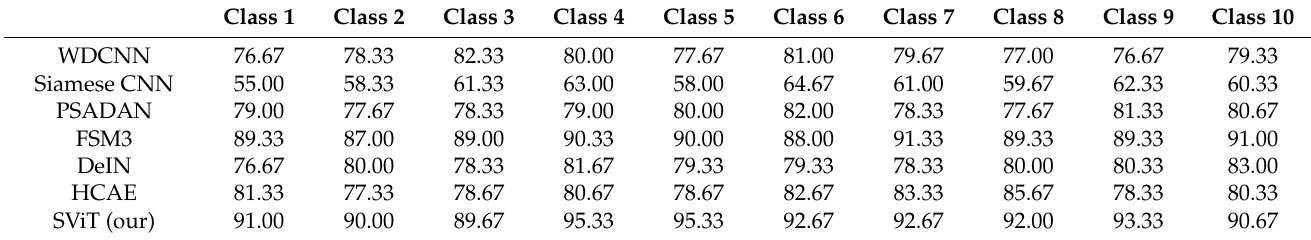
Table 10. Recall (%) comparison for cross-domain task C-A with 6000 training samples on CWRU.